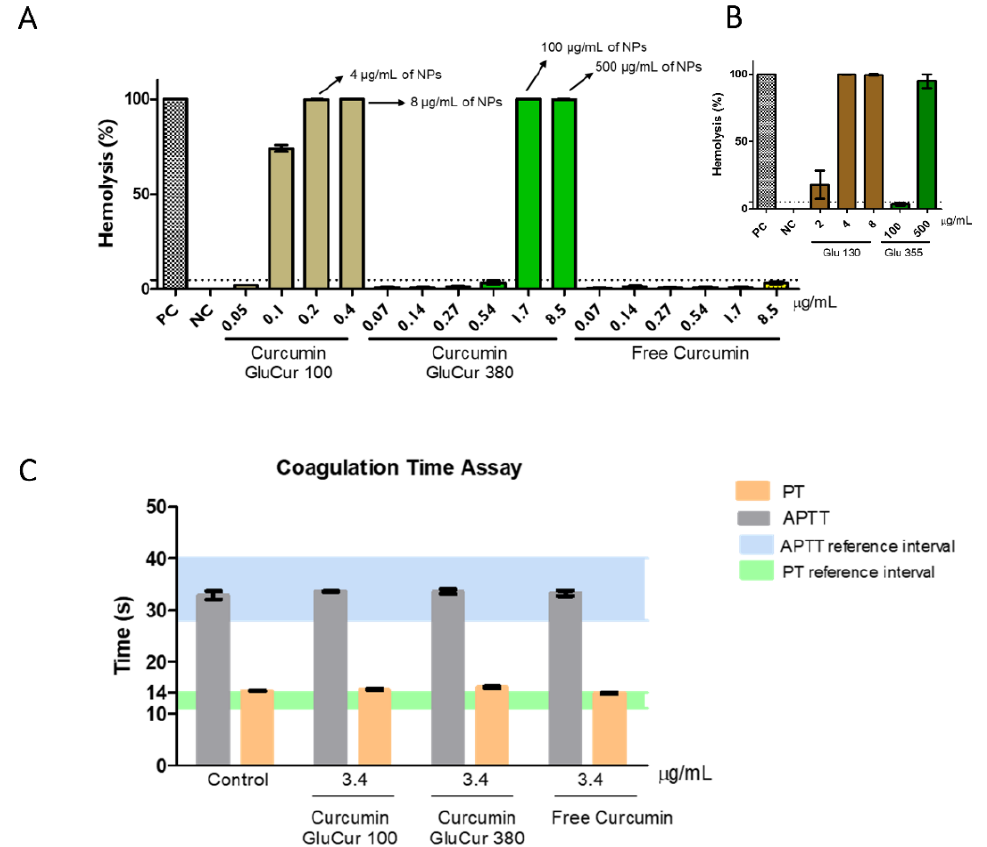
Figure 2. Interaction of curcumin nanocarriers with blood components. ( A ) Human red blood cell lysis (%) induced by several concentrations of curcumin associated with glucan NPs and free cur- cumin ranging from 0.05 to 8.5 µg/mL in human whole blood after 3 h of incubation at 37 °C. Triton-X-100 and PBS were used as the positive (PC) and negative control (NC), respectively (mean ± SEM, n = 3, three independent experiments, each in duplicate). ( B ) Hemolytic effect of blank glucan NPs in the same particle concentrations as curcumin-loaded NPs (for Glu 130 — 2, 4, 8 µg/mL and for Glu 355 — 100, 500 µg/mL) in human whole blood. ( C ) Effect of curcumin and curcumin associated with NPs at 3.4 µg/mL on blood coagulation time after 30 min incubation with platelet-poor plasma. PBS was used as a negative control. The intrinsic and extrinsic coagulation pathways were independently tested by measuring PT (reference range 11–14 s) and APTT (reference range 28–40 s). Results are expressed as the mean ± SEM from at least three independent experiments.